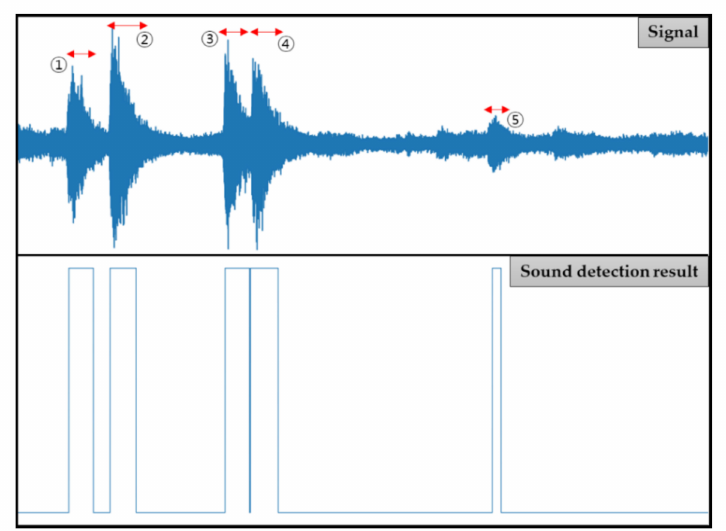
Figure 6. Sound detection result in pigsty using the VAD